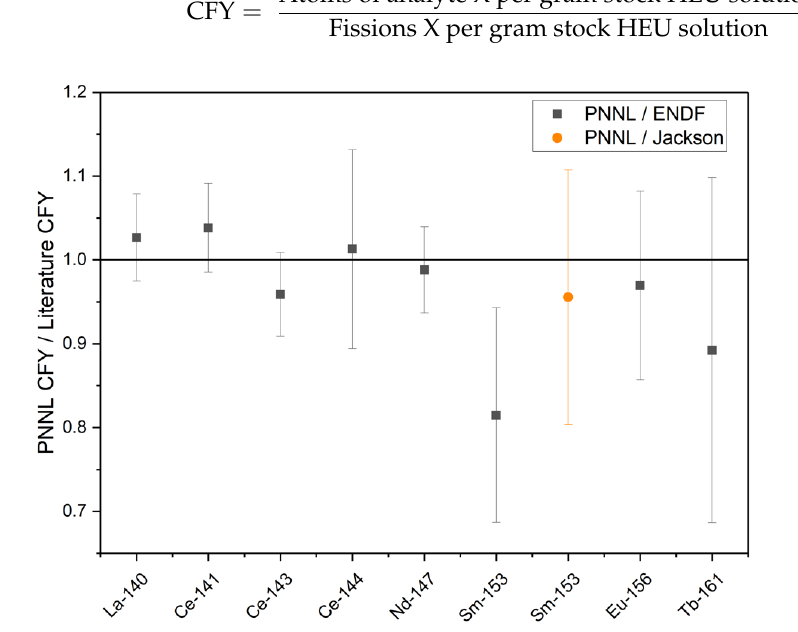
Figure 2. The ratio of the measured PNNL CFY to the CFY reported in ENDF/B-VII.1 or by Jackson et al. (error bars are ± 1 σ ) et al. (error bars are ± 1 σ ) [10].